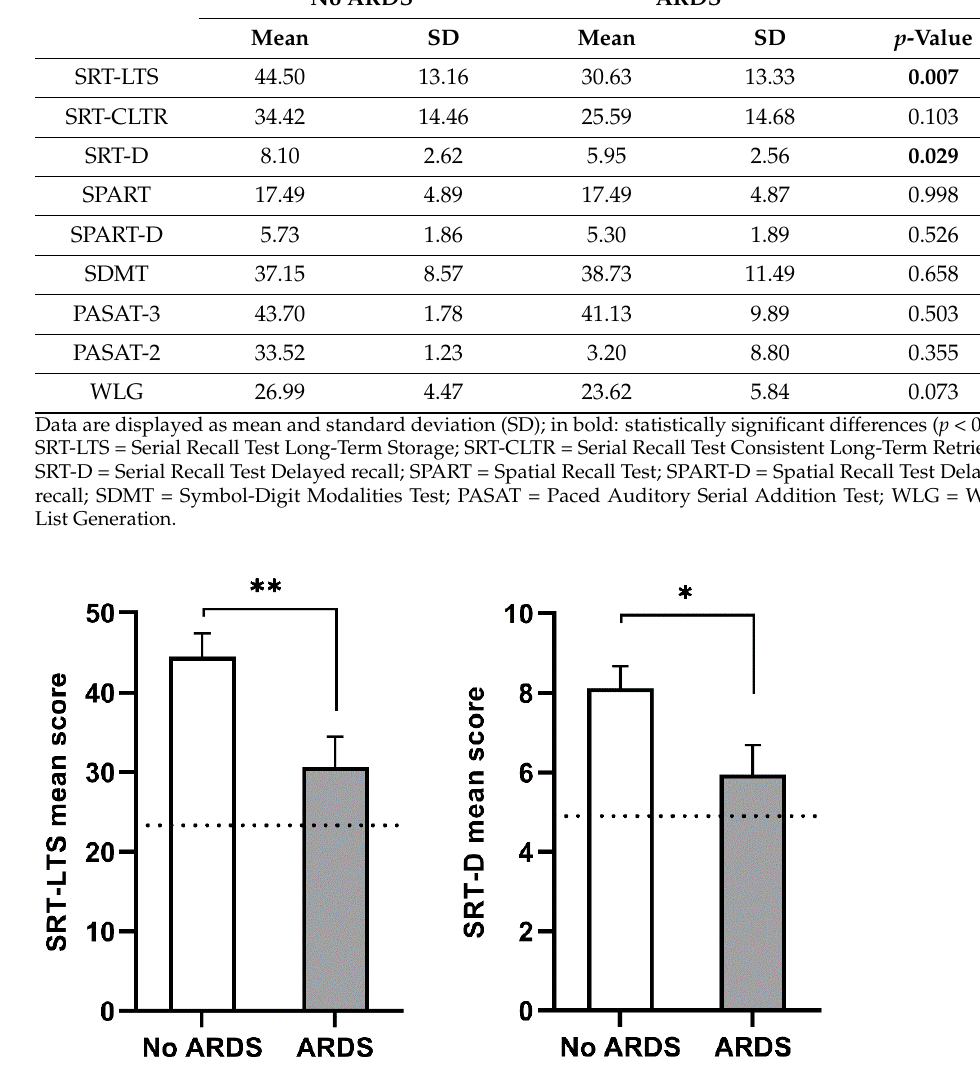
Figure 2. Verbal memory in patients with acute respiratory distress syndrome (ARDS) and without (no ARDS). Left : Serial Recall Test Long-Term Storage (SRT-LTS); right : Serial Recall Test Delayed Recall (SRT-D). Data are presented as a mean score with standard error. The dotted line indicates normative cutoff scores for the SRT-LTS (cutoff ≥ 23.3) and SRT-D (cutoff ≥ 4.9) subtests. Asterisks denote statistical significance (* = p < .05; ** = p < .01)